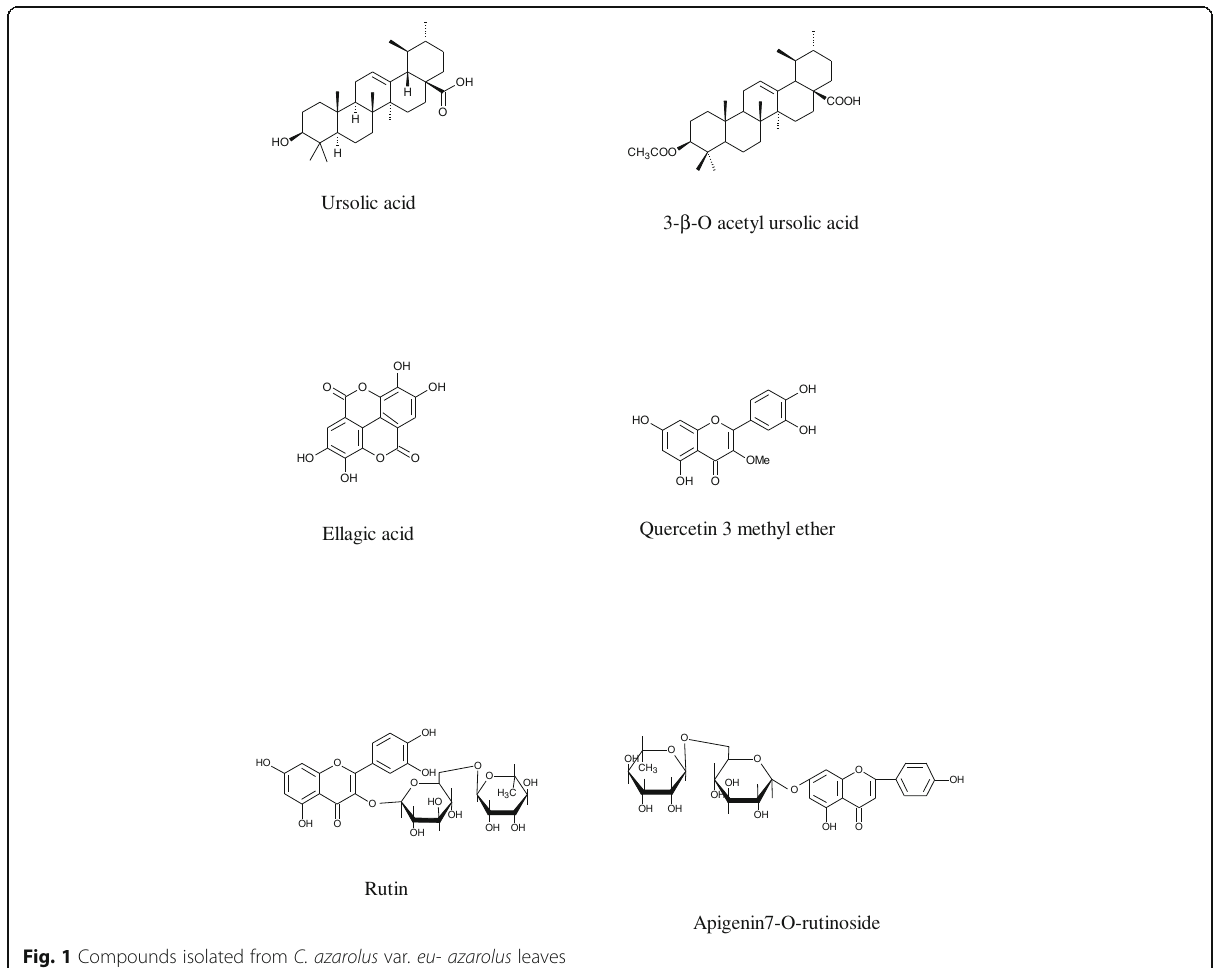
Fig. 1 Compounds isolated from C. azarolus var . eu- azarolus leaves